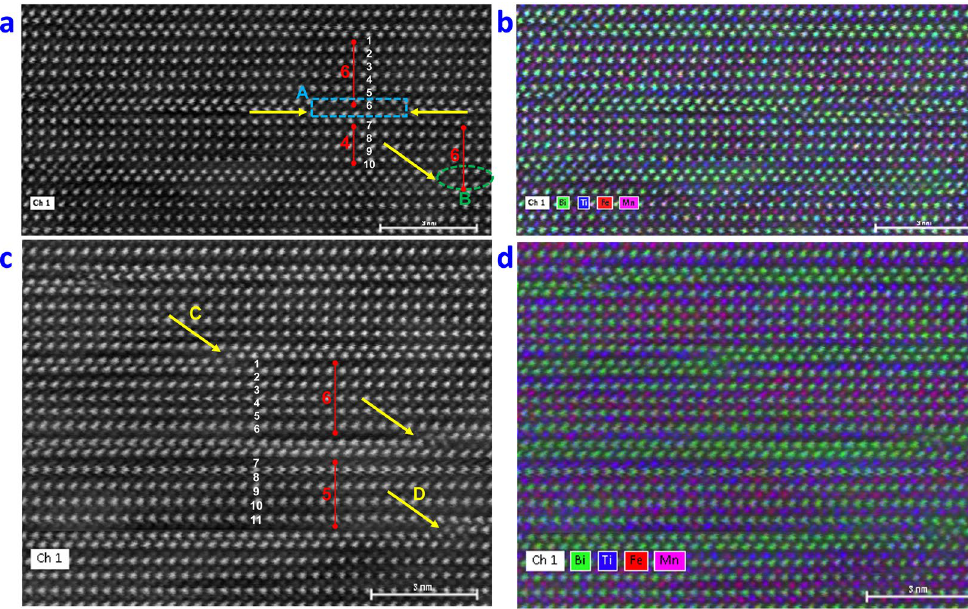
Figure 5. Representative atomic resolution EDX images for B6TFMO-B (( a and b )) and B6TFMO-A (( c and d )) in a region of the crystallite displaying OPBs/stacking faults. ( a and c ) annular dark-field images and ( b and d ) corresponding EDX chemical composition overlay maps showing annular dark-field image (white), Bi (green), Ti (blue), Mn (pink), Fe (red). Yellow arrows demonstrate the positions of the OPBs, the blue rectangle A signifies a stacking fault region and the green ellipsoid B designates a region in the vicinity of an OPB. The numbers displayed in red designate the number of PK layers ( m ) in the region designated by the red bar. The majority of the sample has an m = 5 structure. PK layers used for quantification are labelled by the numbers in white. The relative B-site proportions of Ti, Mn and Fe were quantified by taking horizontal line profiles of the EDX data across regions indicated and are tabulated in Tables 1 and 2.